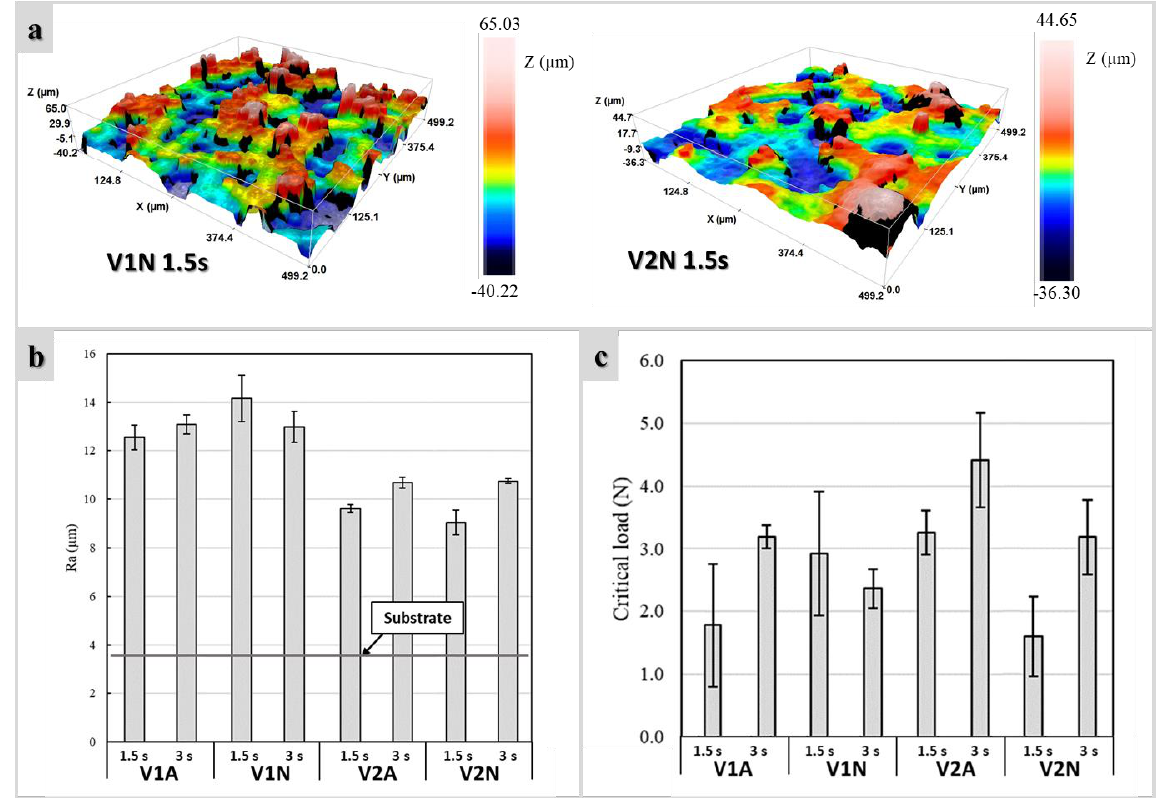
Figure 8. ( a ) 3D topography of argon-treated samples; ( b ) surface roughness measurements at varying processing parameters; ( c ) critical load at varying processing parameters.